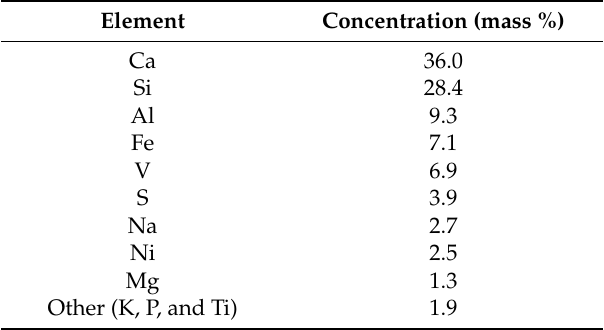
Table 1. Chemical composition of the ash content of ammonia